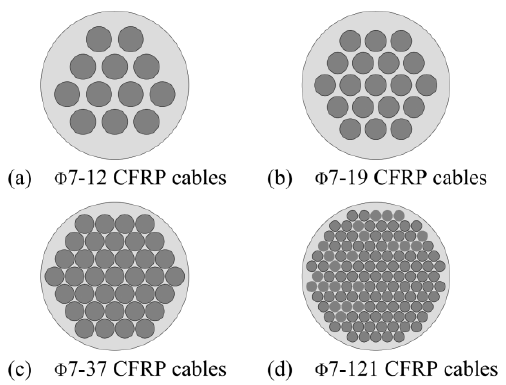
Figure 7. CFRP cables setup.